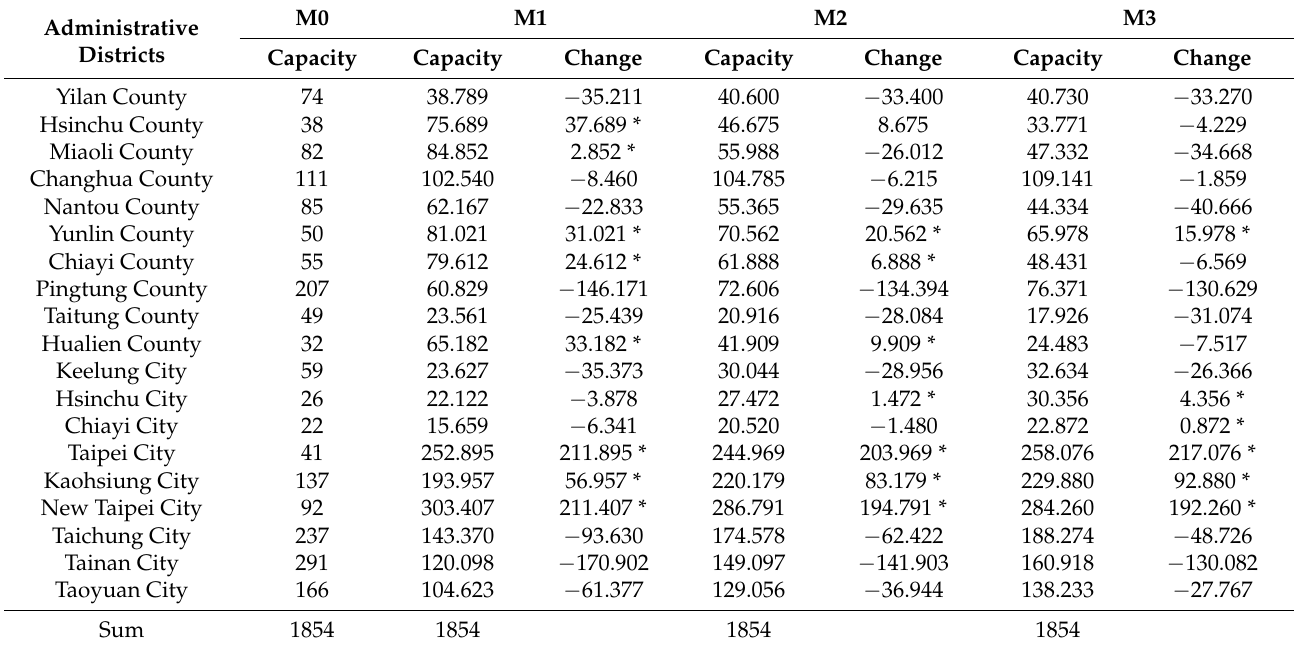
Table 3. Measures of supply capacity allocation of community care resources by method (M0–M3).